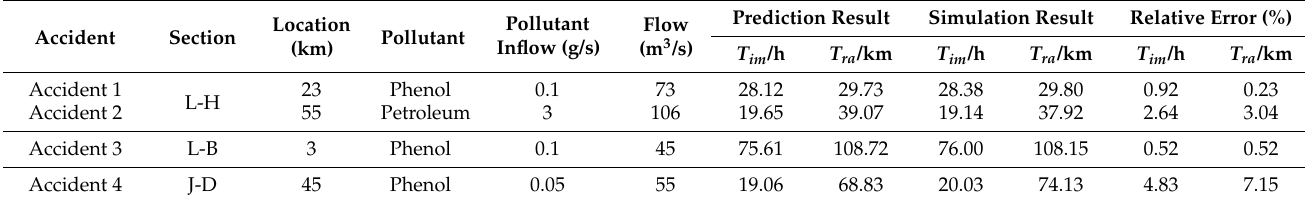
Table 11. Results of the rapid prediction